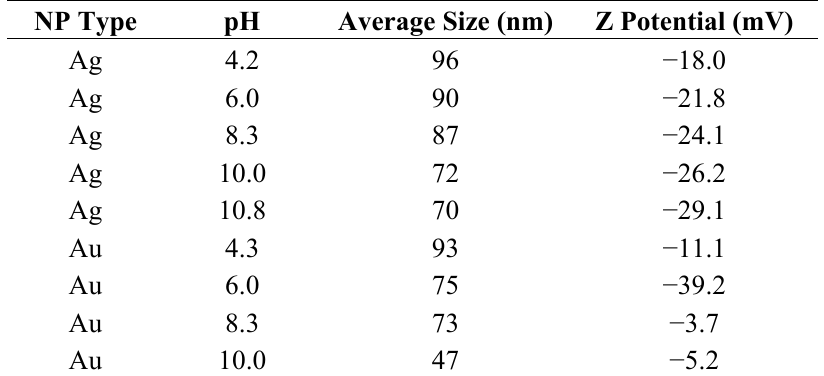
Table 2. Results of the Z-potential and the Z-size for Au NPs and Ag NPs at various pH